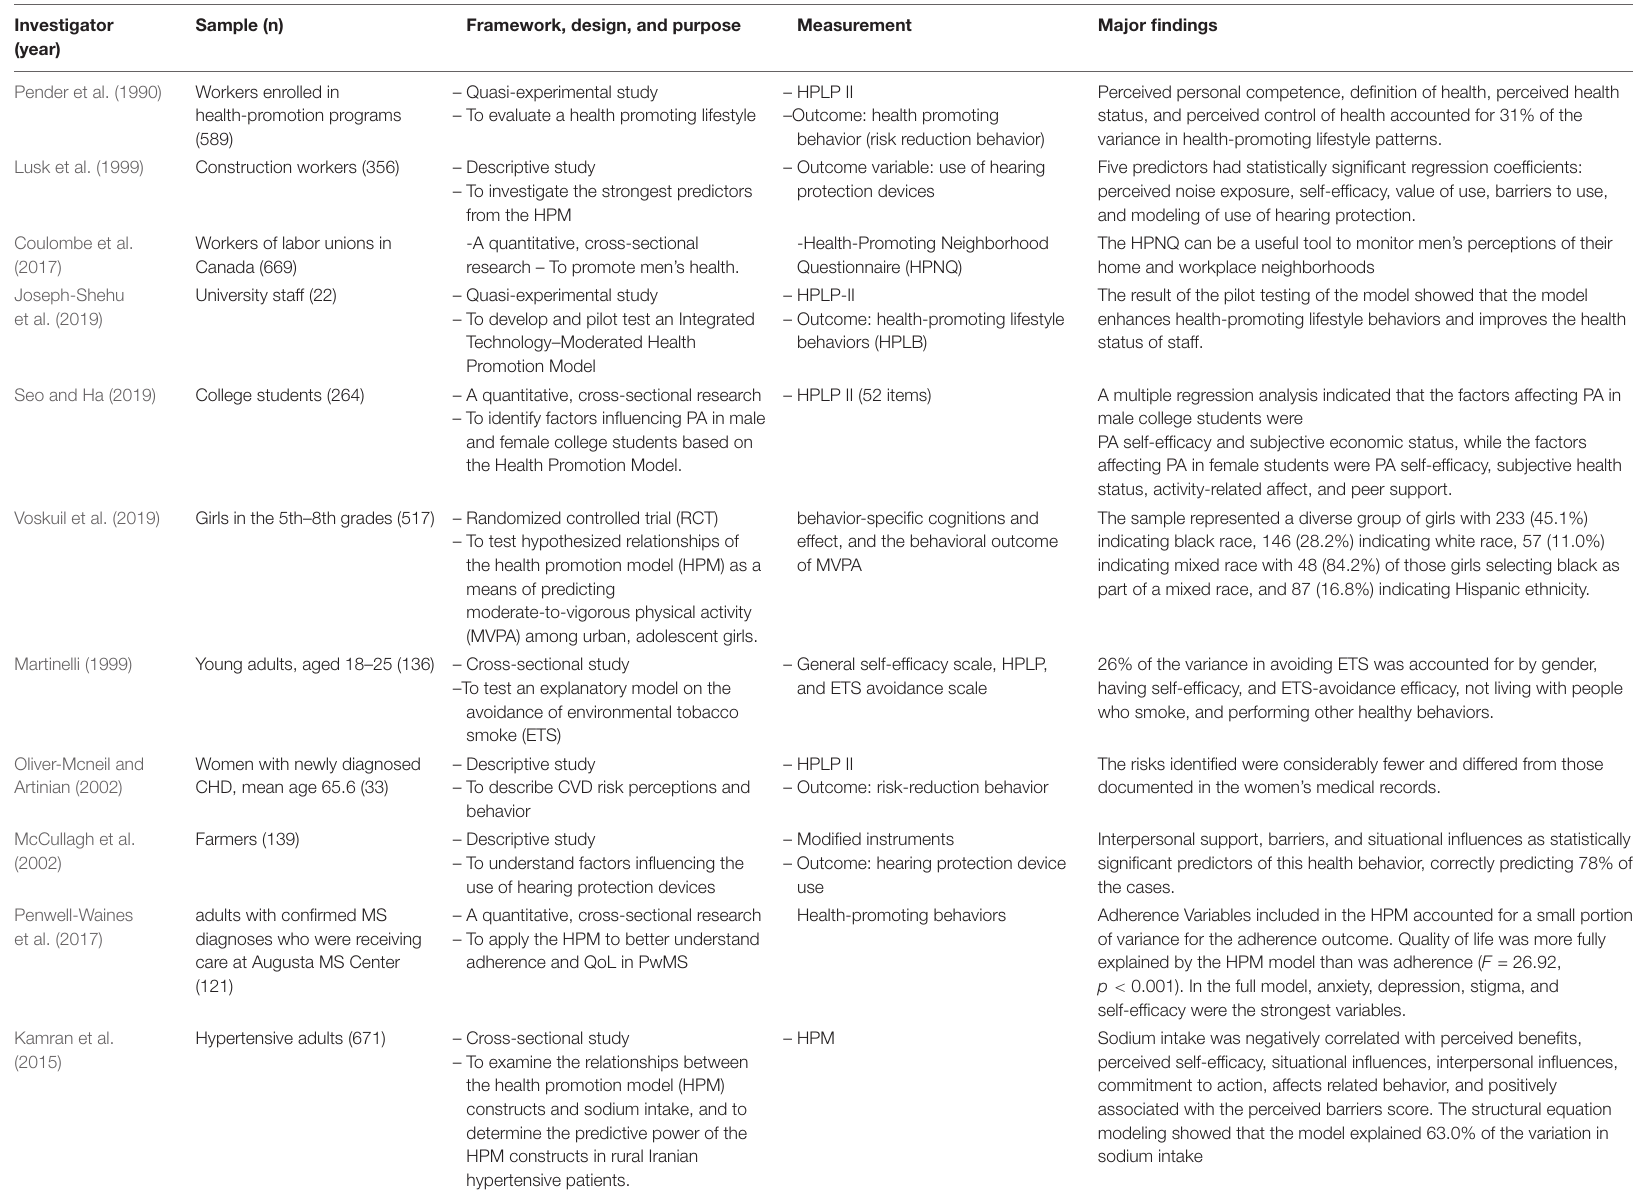
TABLE 1 | Summary of research studies using the health promotion